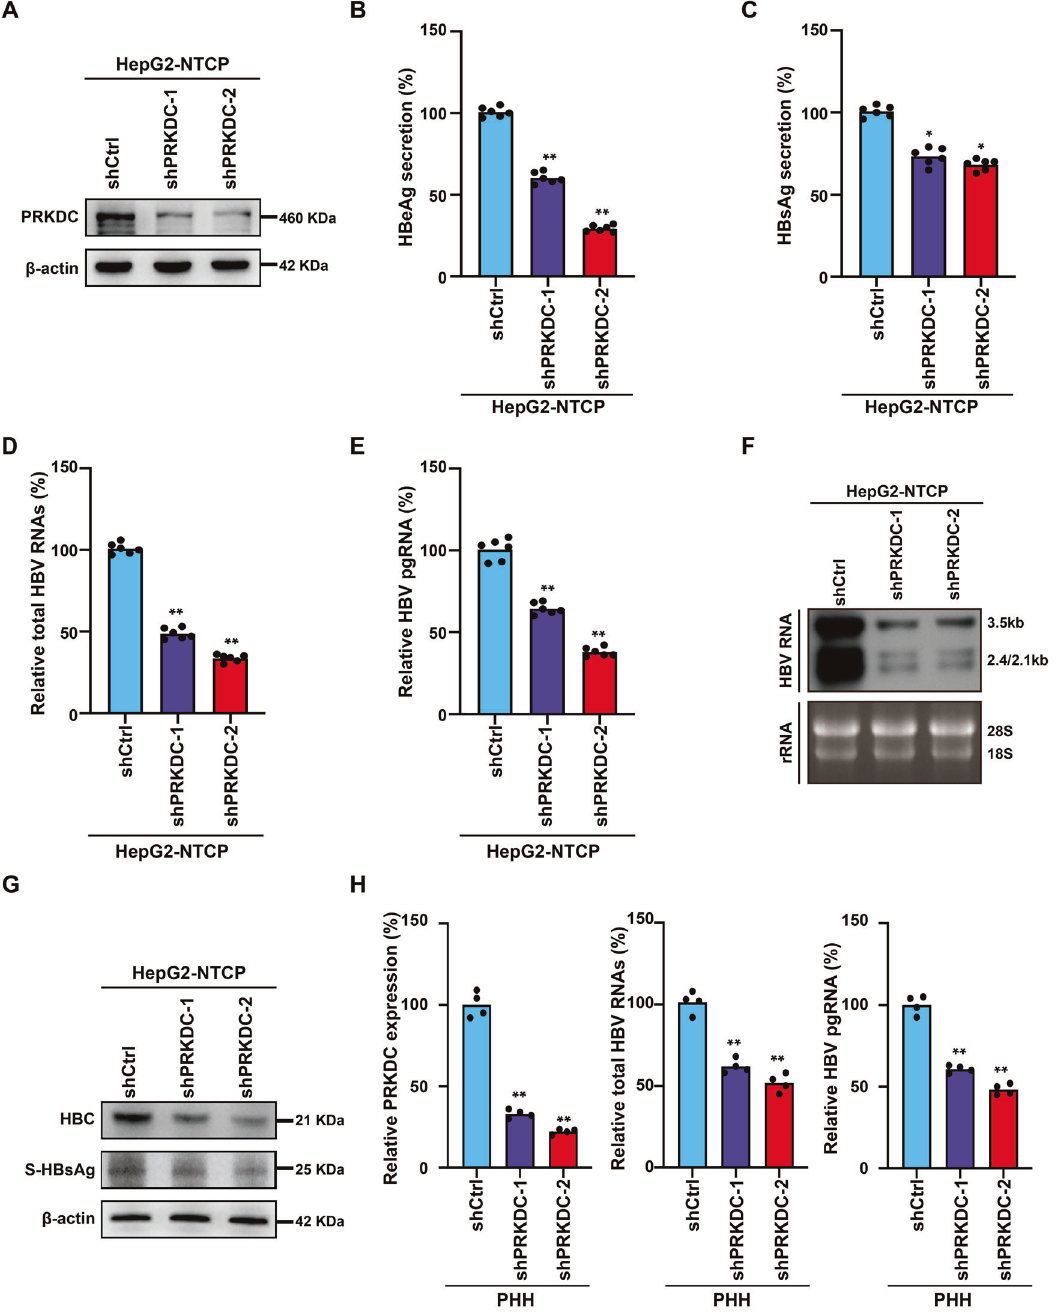
Fig. 2 PRKDC silencing inhibits HBV transcription. A The knockdown ef fi ciency was veri fi ed by WB analysis with antibodies against PRKDC. β -actin was used as a loading control. B , C PRKDC suppression decreased HBeAg ( B ) and HBsAg ( C ) secretion, as detected by ELISA kit. D – F The expressions of total HBV RNAs and 3.5-kb pgRNA were down regulated upon PRKDC disruption. HBV RNAs ( D ) and pgRNA ( E ) were analyzed by real-time PCR using speci fi c primers and Northern blotting ( F ). Ribosomal RNAs (28S and 18S) served as loading controls. G HBsAg and HBc were analyzed by immunoblotting analysis. H PRKDC suppression in HBV-infected PHHs decreased total HBV RNAs and 3.5-kb RNA. * P < 0.05; ** P <